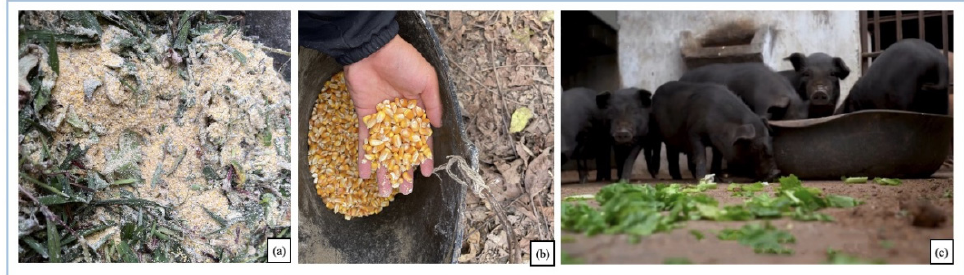
Figure 4. Commonly cultivated plants in artificial supplemented. ( a ) The maize flour mixed with wild forage, fed piglets around 4–5 months of age; ( b ) the corn kernels, fed piglets after 6 months of age; ( c ) the cultivated plants for daily feeding. (Photo by Yanan Chu, August 2022, ( a ) photographed in Yinpo Village, ( b , c ) photographed in Zhongyuan Village).